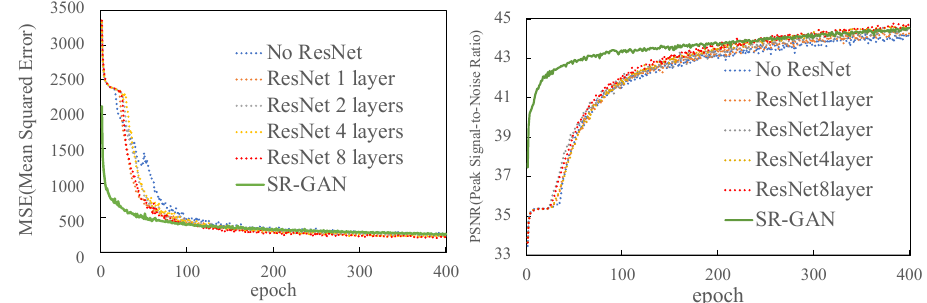
Figure 4. MSE and PSNR between the generator output in our proposed scheme with changes in ResNet size and SR-GAN (input is coarse-grained data).